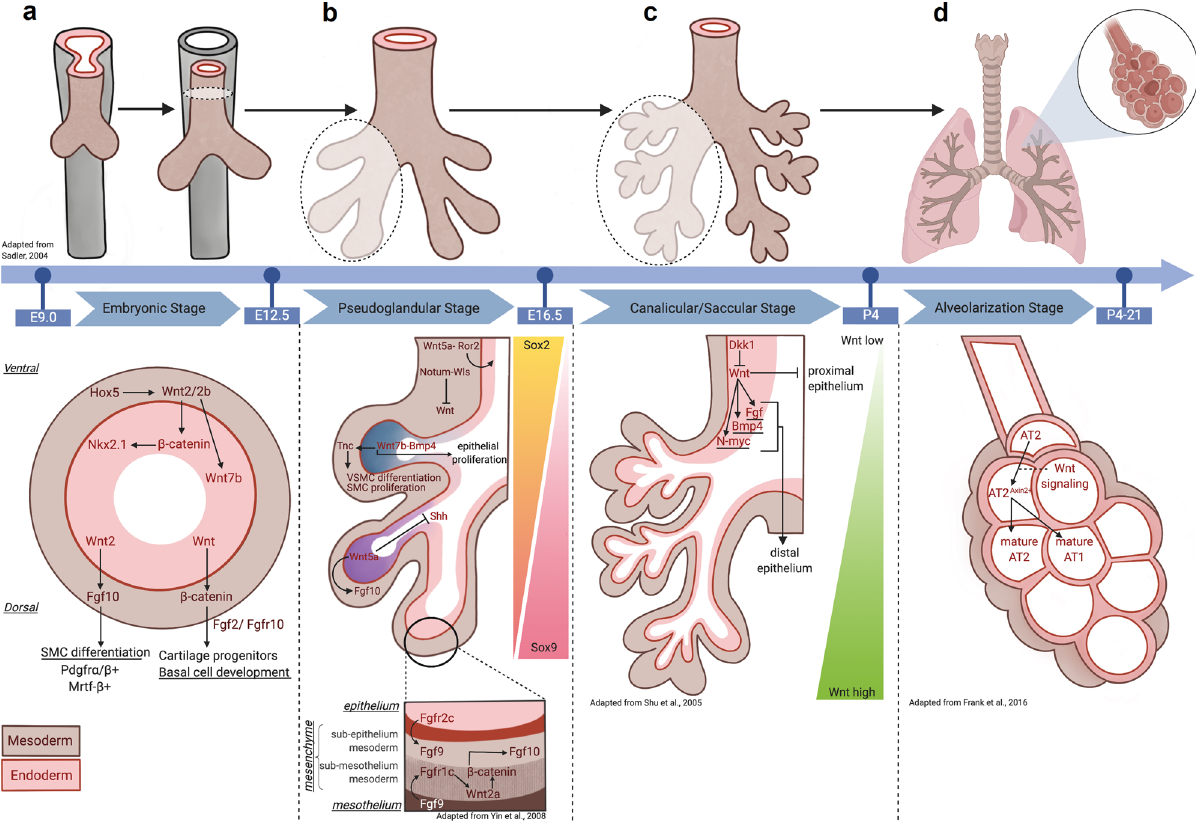
Fig. 2 Wnt signals mediate epithelial – mesenchymal interactions during lung development. a During the embryonic stage (E9.0 – 12.5) of development, lung bud emerges from tracheal-esophageal septation occurs 9 . Mesenchymal (brown) HOX5 spatiotemporally regulates endodermal (pink) Wnt2/2b